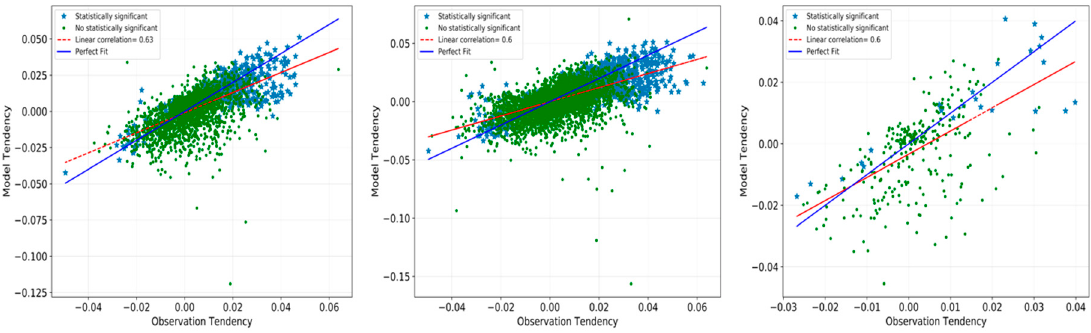
Figure 11. Monthly streamflow tendencies for values with KGE > 0.65 ( left ), KGE > 0.5 ( middle ), and KGE > 0.8 ( right ).